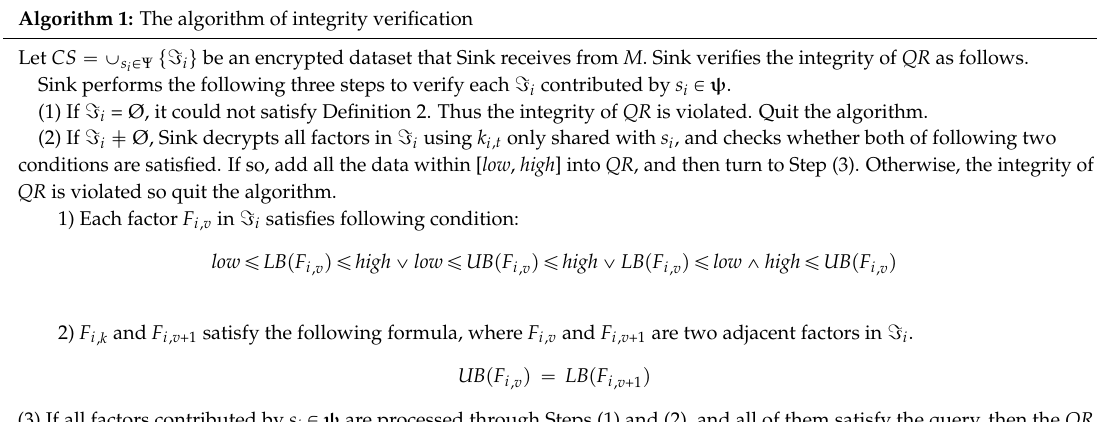
Algorithm 1: The algorithm of integrity